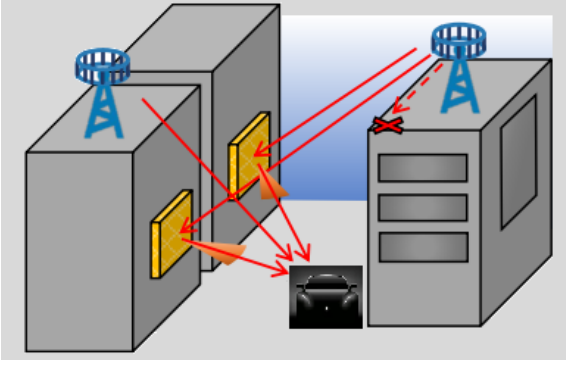
Figure 4. Localization in absences of LoS path [29].